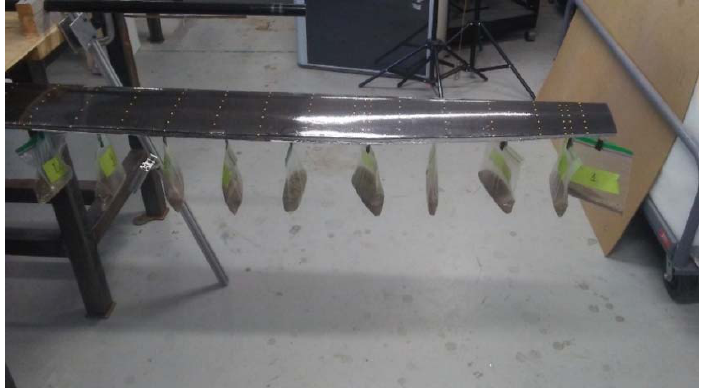
Figure 13. Morphing wing load test.